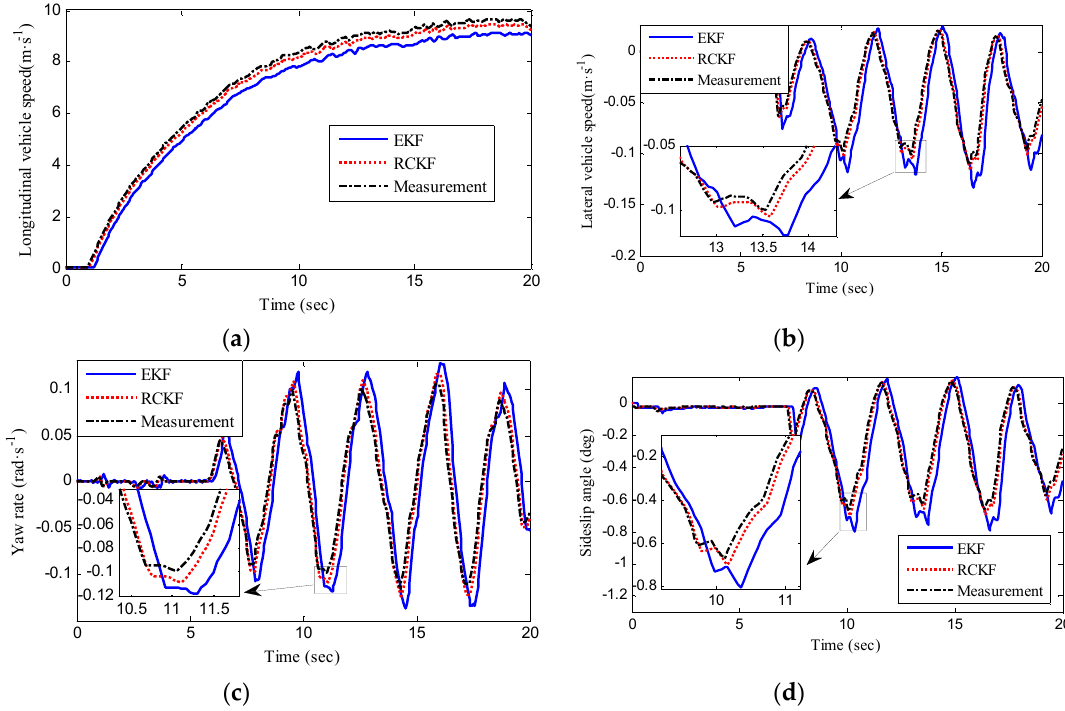
Figure 7. Measured running states of vehicle road test: ( a ) Longitudinal vehicle acceleration; ( b ) lateral vehicle acceleration; ( c ) steering wheel angle; ( d ) four-wheel rotation speed.